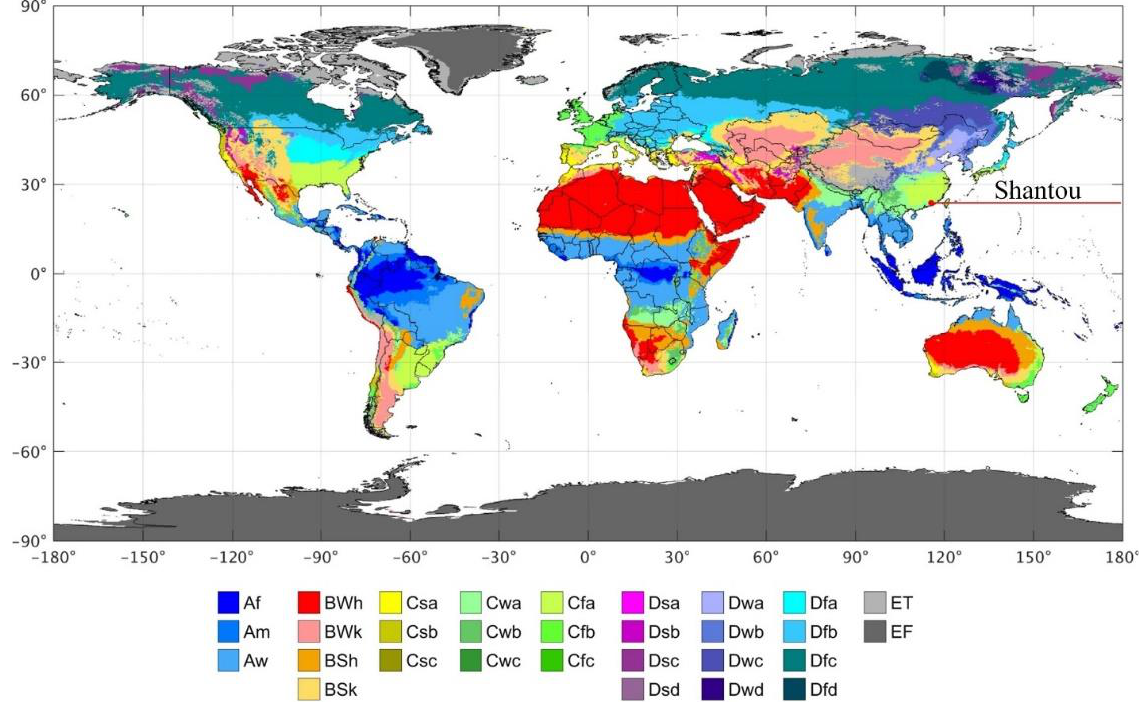
Figure. 1 The present-day map (1980–2016) of Köppen-Geiger climate classification